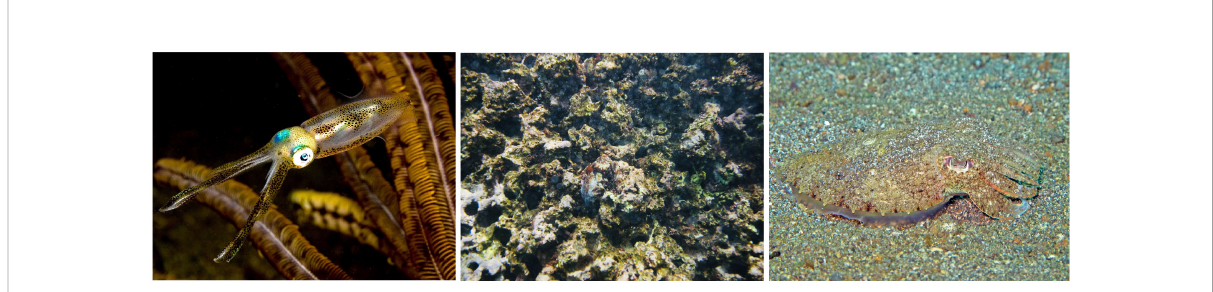
FIGURE 4 Cephalopod camou fl age (L-R) Big fi n reef squid (Sepioteuthis lessoniana) masquerading as seaweed, Octopus sp. background matching against coral, and broadclub cuttle fi sh (Sepia latimanus) displaying sand-like coloration. Image credits in order are: Nick Hobgood, CC BY SA 3.0, https://commons.wikimedia. org/wiki/File:Sepioteuthis_lessoniana_(Big fi n_reef_squid).jpg; Alana Barthel, CC BY 4.0, https://commons.wikimedia.org/wiki/File:Camou fl age_octopus.jpg; Lakshmi Sawitri, CC BY 2.0, https://commons.wikimedia.org/wiki/File:Lembeh81_5-12-11_-_43_cuttle fi